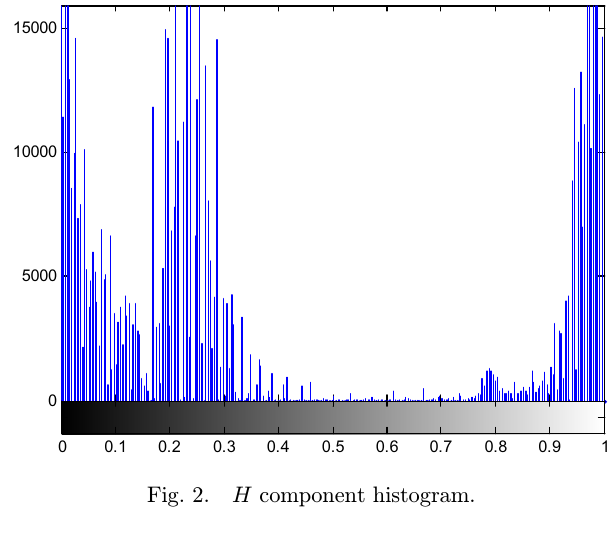
Fig. 1. S component histogram.